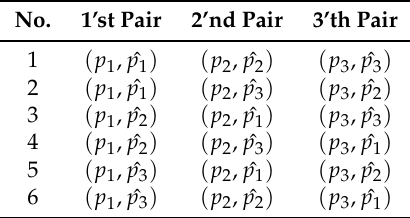
Table 3. Possible assignments ( p denotes known parameters of function f ; ˆ p denotes estimated parameters of function ˆ f ).